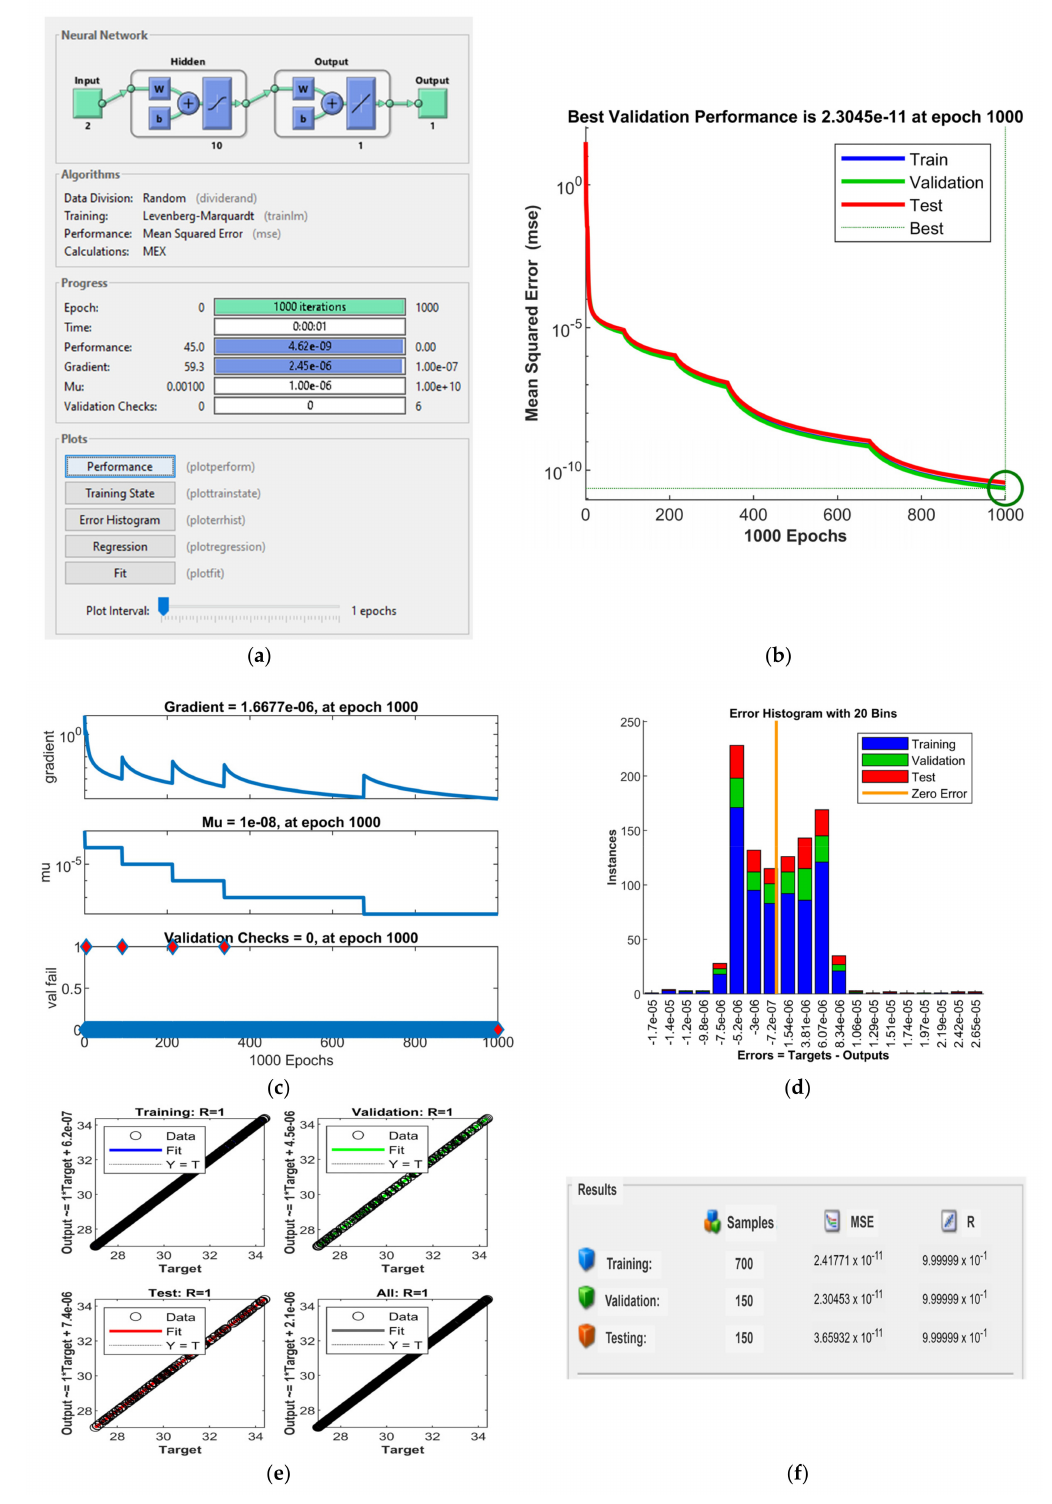
Figure 25. Neural network training: ( a ) NNTOOL for NN training in MATLAB; ( b ) performance plot of neural network; ( c ) training state plot; ( d ) error histogram; ( e ) regression plot; ( f ) results of trained